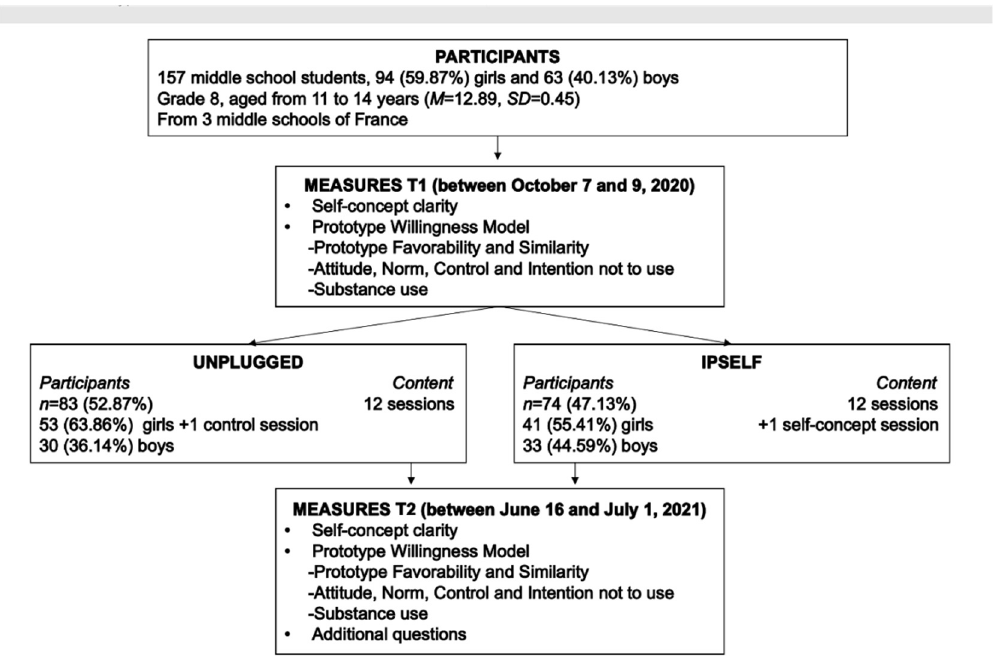
Figure 1. Flowchart of the procedure.